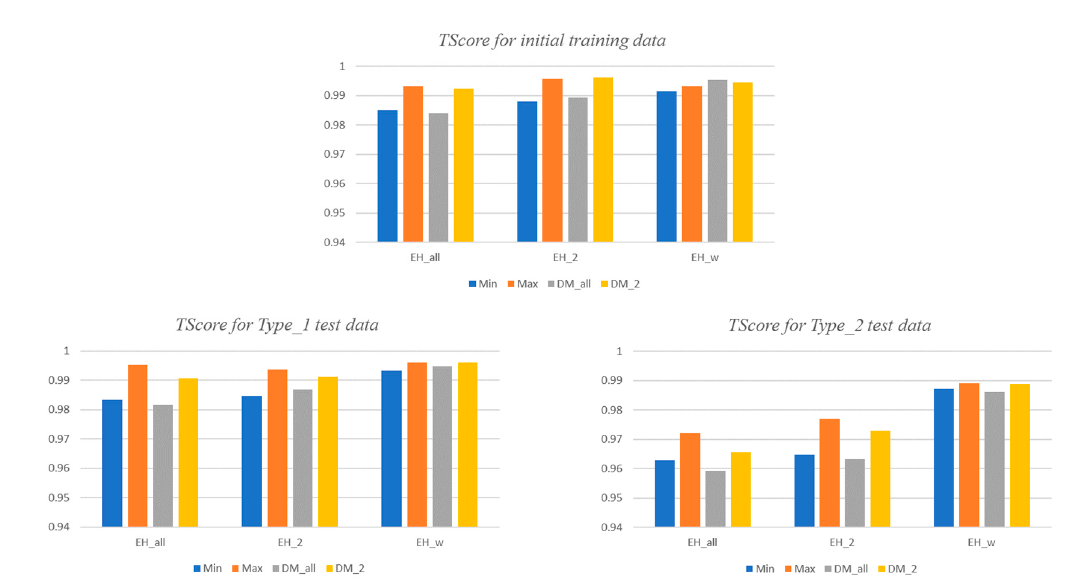
Figure 13. TScore of the enhanced models for initial training data and test data.